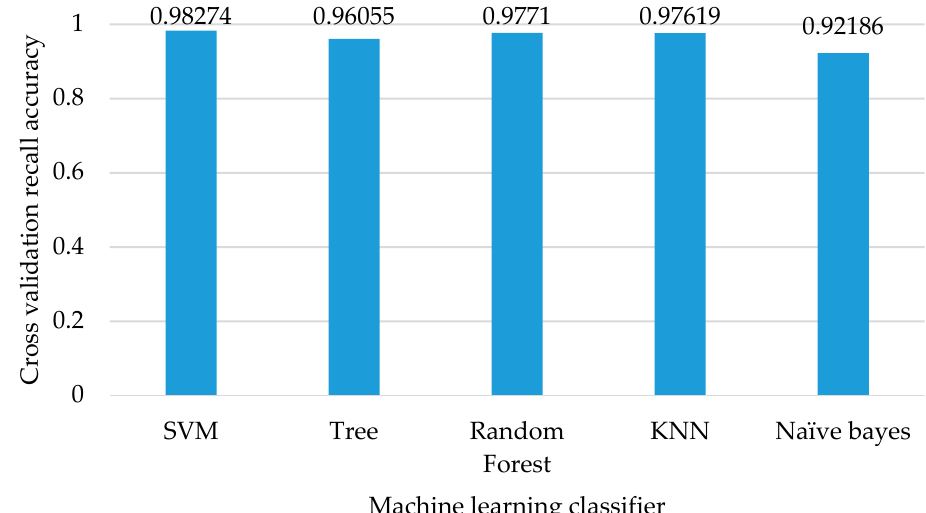
Figure 14. Recall accuracy comparison between SVM (RBF kernel) and other optimized machine learning classifiers.